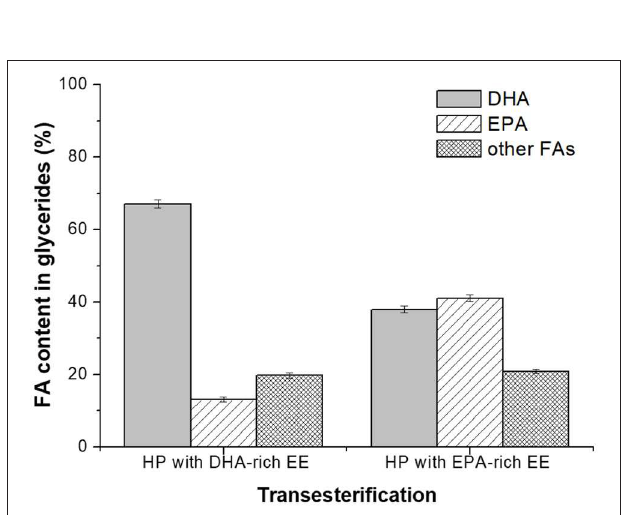
FIGURE 6 | Novozym 435-catalyzed transesterification of glycerides with DHA- or EPA-rich EE